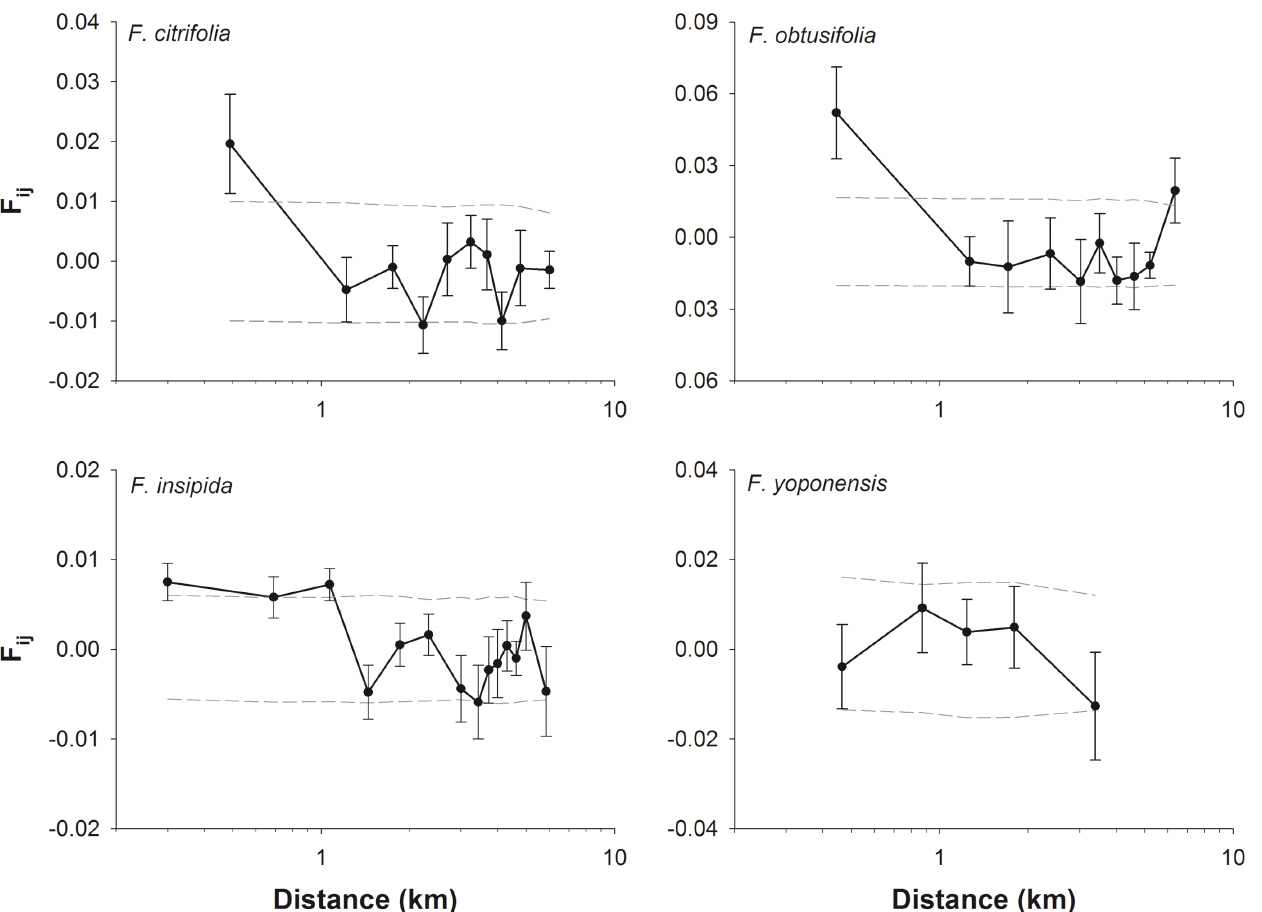
Fig 2. Average kinship over distance for the investigated fig species. Pairwise kinship is determined by Loiselle´s kinship coefficient ( F ij ) for F . citrifolia (n ind = 62, n comp = 236), F . obtusifolia (n ind = 59, n comp = 214), F . insipida (n ind = 190, n comp = 1795) and F . yoponensis (n ind = 37, n comp = 133) Dotted lines represent 95% confidence interval. Depending on the pairwise kinship, scales on the y axis vary among graphs. (n ind = number of sampled individuals, n comp = number of pairwise comparisons per distance